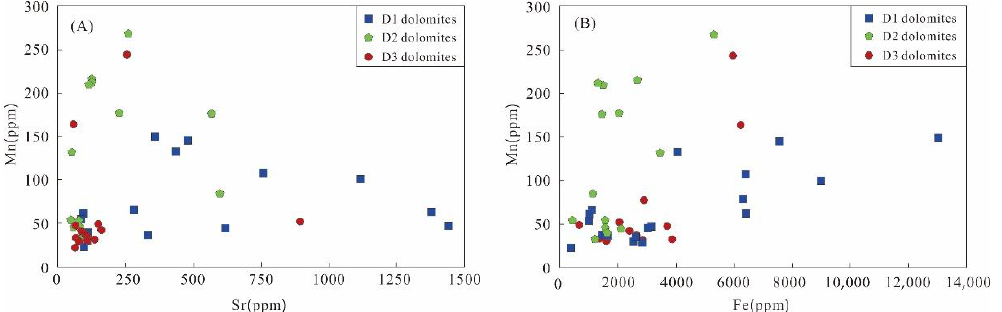
Figure 6. ( A ) Cross-plot of Mn versus Sr abundances in the Cambrian dolomites. ( B ) Cross-plot of Mn versus Fe abundance in the Cambrian dolomites.